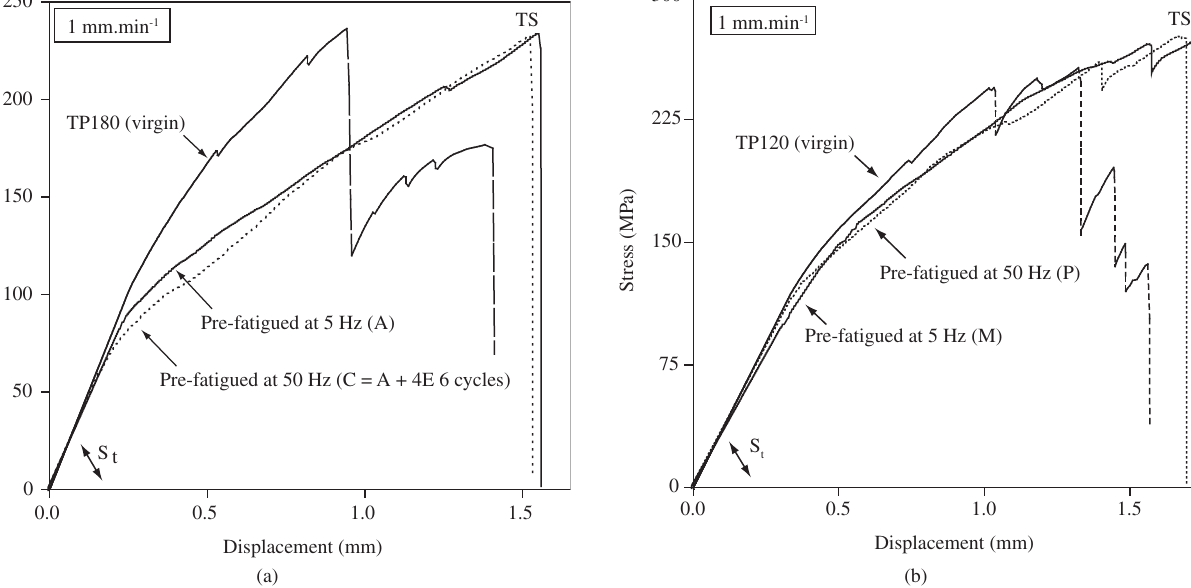
Figure 5. Quasi-static residual tensile stress-displacement curves for specimens A-C (a), and M-P (b). Life-span of specimens M and P is 1.4 10 6